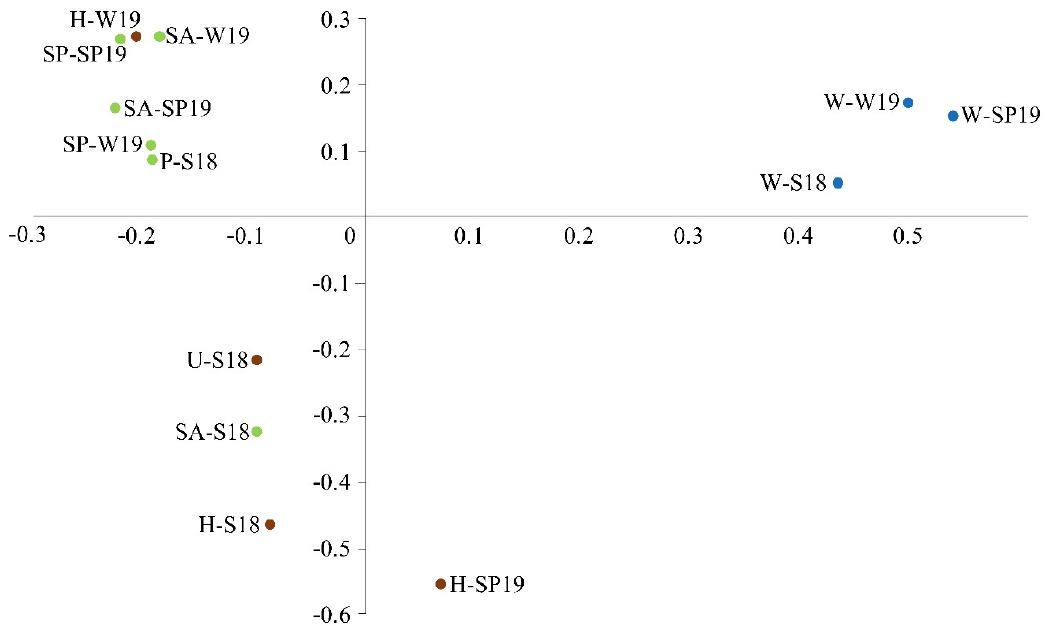
Figure 9. Principal coordinate analysis (PCoA) based on Bray–Curtis dissimilarity of all the samples analyzed: brown points represent biofouling samples collected from the floating platform; green points represent the biofilm samples from the planting media and blue points represent samples from the water. Codes: biofouling samples from the surface of the floating platform (H = non ‐ planted holes and U = Under surface); biofilm samples from the planting media (SP = Spartina maritima ; SA = Sarcocornia perennis ; and P = Phragmites australis ) and water samples (W); S18 = Summer of 2018; W19 = Winter of 2019 and SP19 = Spring of 2019.